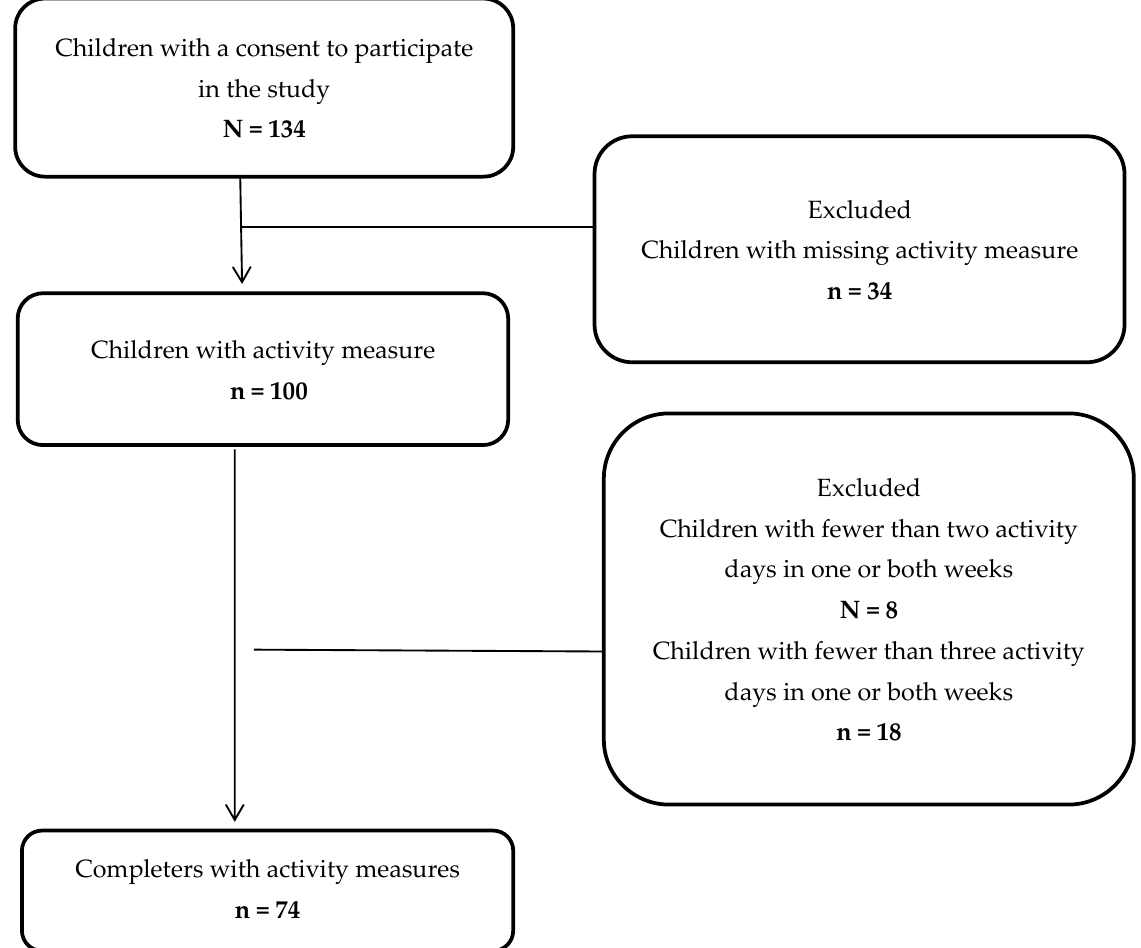
Figure 1. Flowchart of the study population.